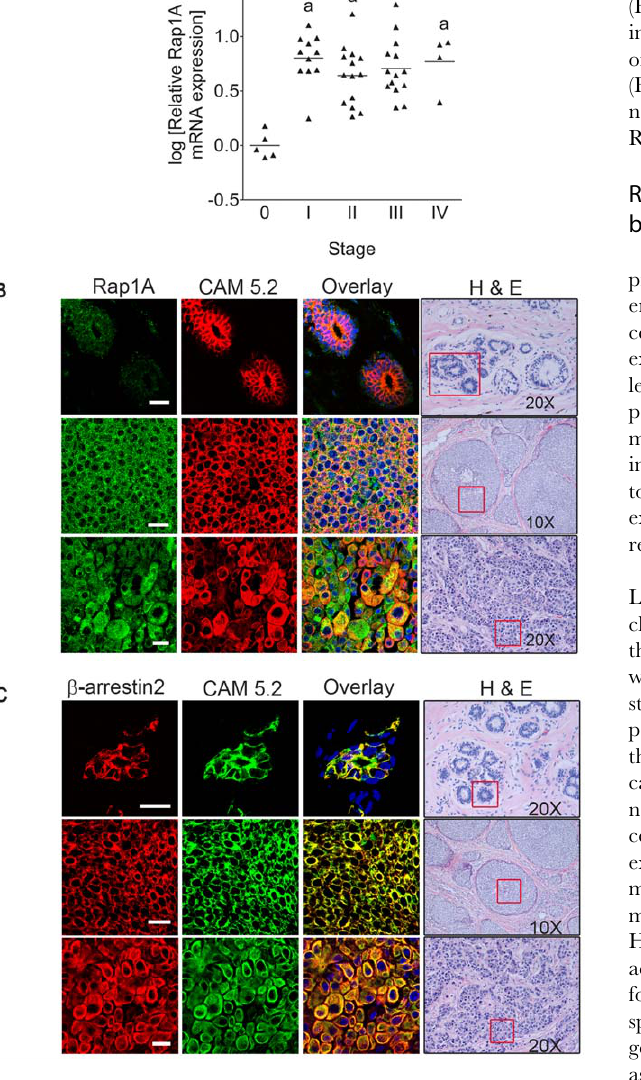
Figure 1. Rap1A is abundantly expressed in human breast tumors. (A) Patient breast tumors from Stages I–IV of the disease express higher levels of Rap1A mRNA compared to non-diseased Stage 0 samples, as determined by quantitative real-time PCR. Data points shown are log-transformed values of relative mRNA expressions compared to average expression in Stage 0 samples. Levels of b -actin were used by the manufacturer to pre-normalize samples. One-way ANOVA statistical analysis was performed on the log-transformed relative expression values and a Dunnett’s multiple comparison post- hoc test was conducted. a, p , 0.01, compared to Stage 0. (B) Immunofluorescence and confocal microscopy on formalin-fixed and paraffin-embedded human tissue samples using (B) a rabbit anti-Rap1A polyclonal antibody followed by Alexa-Fluor 488 secondary antibody (green) and (C) a goat anti- b -arrestin2 polyclonal antibody followed by Alexa-Fluor 555 secondary antibody. In order to distinguish cells of epithelial origin, staining for cytokeratin CAM 5.2 was performed using a mouse monoclonal anti-CAM 5.2 antibody (red). Hematoxylin and eosin staining of normal and tumor sections from each group were examined (representative red boxes). Images are representative of four independent experiments. Scale bar, 20 m